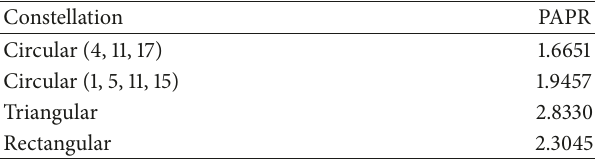
Table 2: PAPRs of different constellation shaping schemes. Constellation PAPR